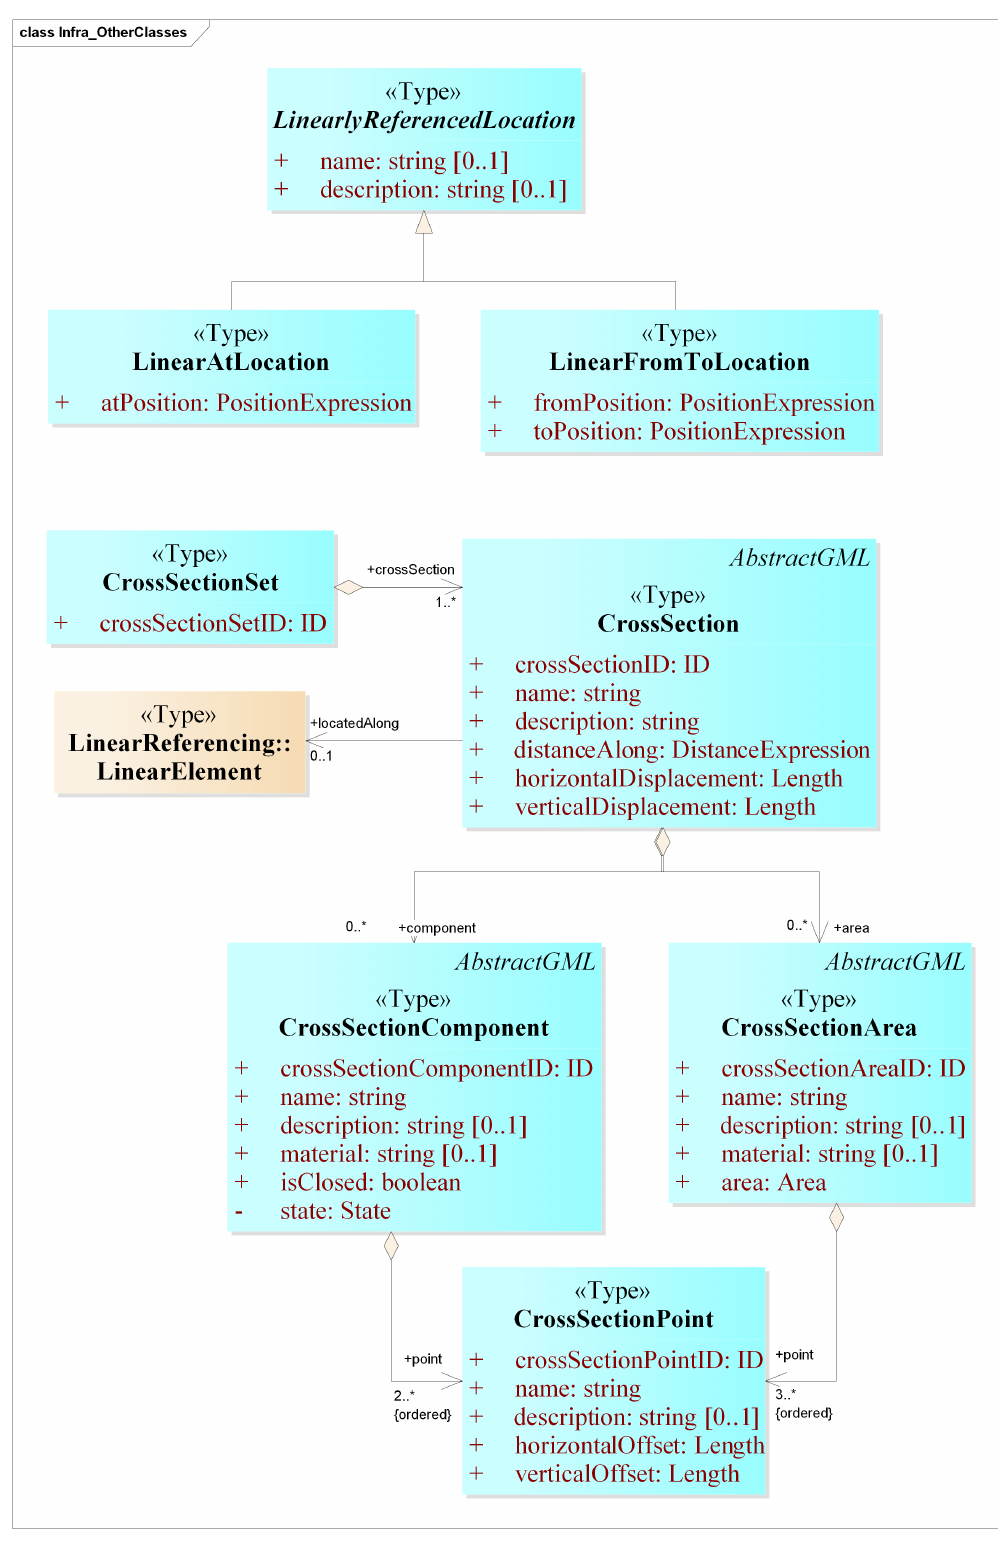
Figure A5. The UML excerpt depicts the LandInfra classes CrossSection and LinearlyReferencedLocation in the CityGML Infra